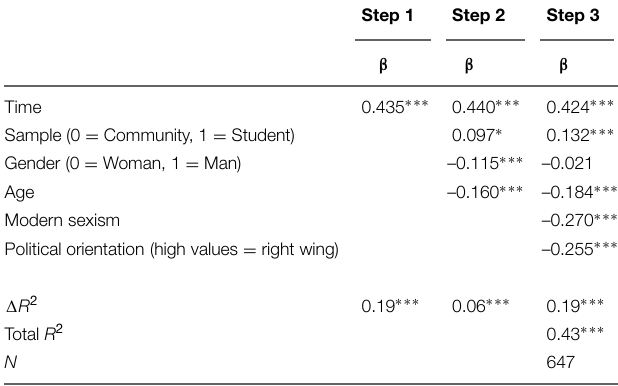
TABLE 5 | Hierarchical multiple regression analyses predicting attitudes to hen .